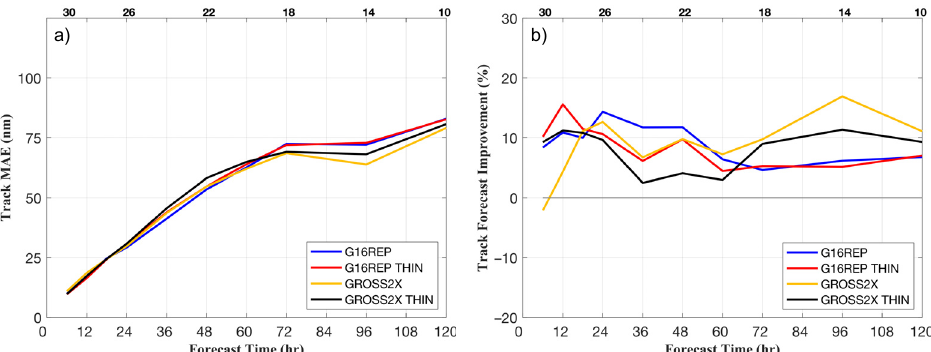
Figure 7. Hurricane Irma (2017) HWRF track forecast MAE (nm) verified against NHC Best Track for G16REP (blue), G16REP THIN (red), GROSS2X (gold), and GROSS2X THIN (black) in ( a ). The percentage improvement in MAE relative to BASE is shown in ( b ). The number of verifying forecasts for each lead time is shown in black across the top of each plot.